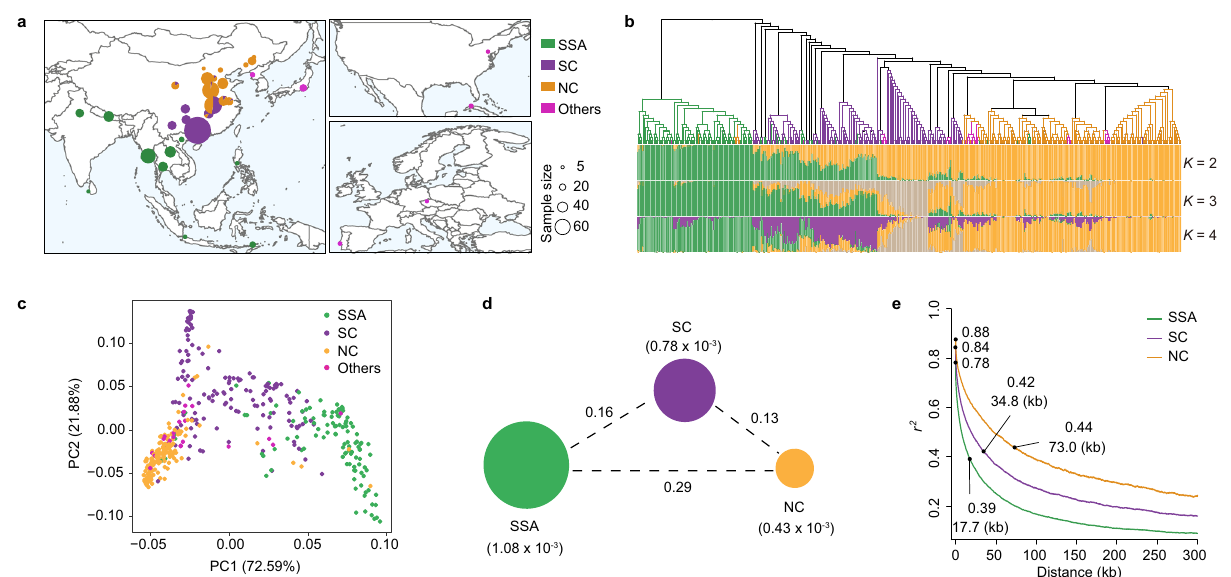
Fig. 3 | Population structure and genetic divergence of rice bean landraces. a The geographic distributions of 440 rice bean landraces. SSA South & Southeast Asia, SC South China, NC North China. The size and color of each pie chart repre- sent the sample size in a speci fi c geographic location. The map was created using the map_data() function in the R package ggplot2. b Phylogenetic tree and model- based clustering ( K =2 – 4) of 440 sequenced landraces. c Scores plot from a prin- cipal component analysis, supporting the division of the landraces into three geographicalgroups(SSA, SC, and NC). d Summary ofnucleotidediversity ( π ) and